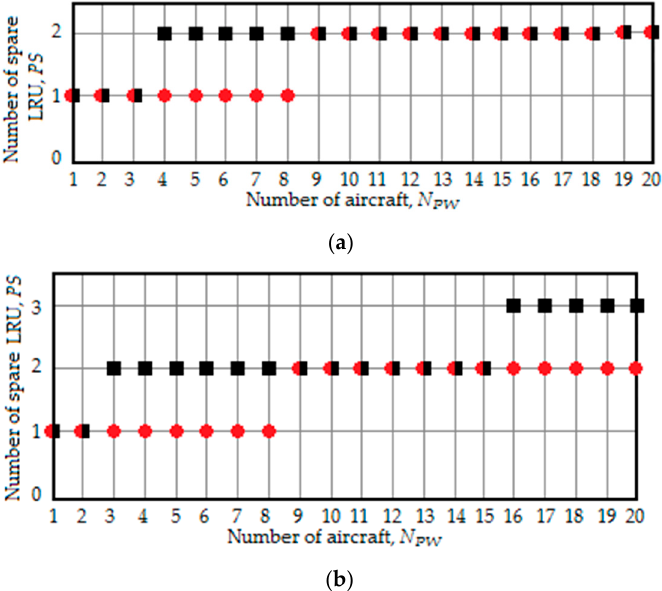
Figure 13. The dependency of the optimal quantity of spare LRU on the quantity of aircraft for the third PWM option ; ( a ) 𝜃 = 1 × 10 (cid:2879)(cid:2872) h (cid:2879)(cid:2869) , red circles: 𝑃 (cid:3033)(cid:3039)(cid:3036)(cid:3034)(cid:3035)(cid:3047)(cid:3007)(cid:3017) = 1 × 10 (cid:2879)(cid:2872) , black squares: 𝑃 (cid:3033)(cid:3039)(cid:3036)(cid:3034)(cid:3035)(cid:3047)(cid:3007)(cid:3017) = 1 × 10 (cid:2879)(cid:2871) ; ( b ) 𝑃 (cid:3033)(cid:3039)(cid:3036)(cid:3034)(cid:3035)(cid:3047)(cid:3007)(cid:3017) = 1 × 10 (cid:2879)(cid:2872) , red circles: 𝜃 = 1 × 10 (cid:2879)(cid:2872) h (cid:2879)(cid:2869) , black squares: 𝜃 = 1 × 10 (cid:2879)(cid:2871) h (cid:2879)(cid:2869) .